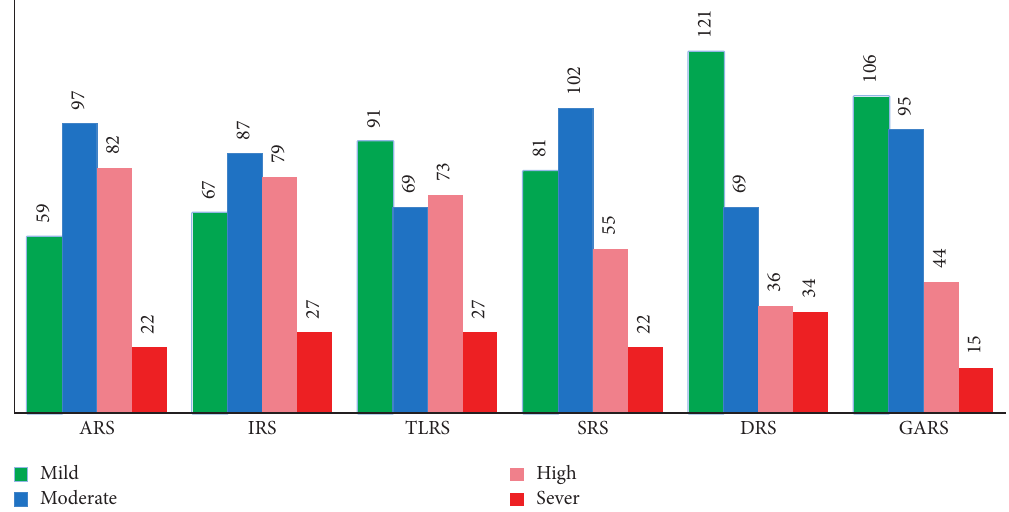
Figure 1: The level of stress caused by six domains of medical student stressors, N � 260, AU, January